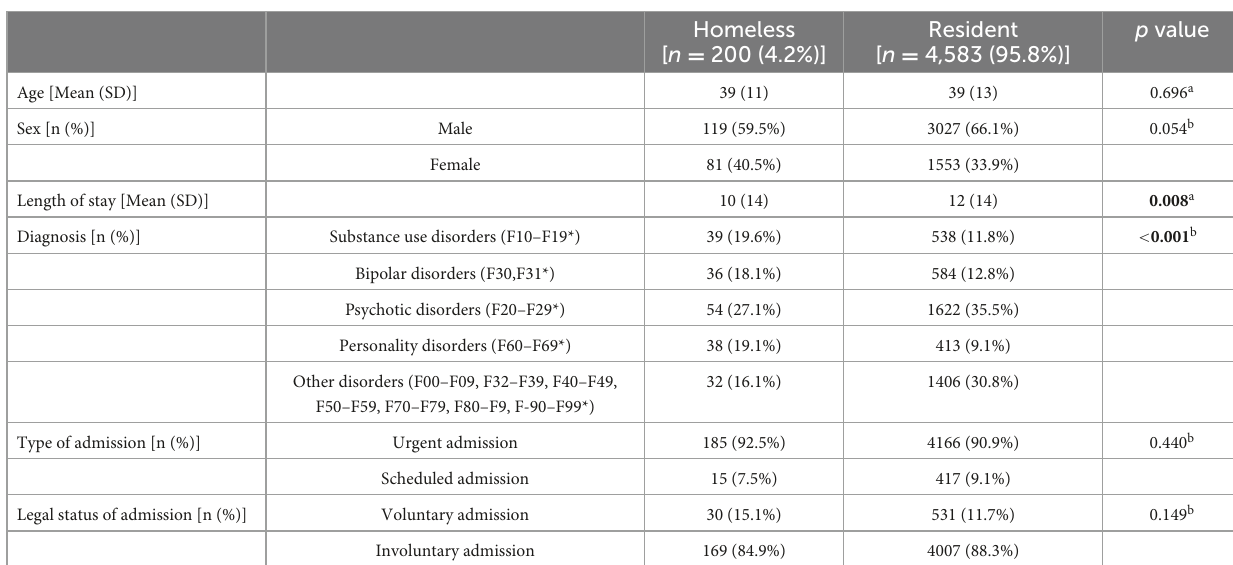
TABLE 1 Baseline variables.